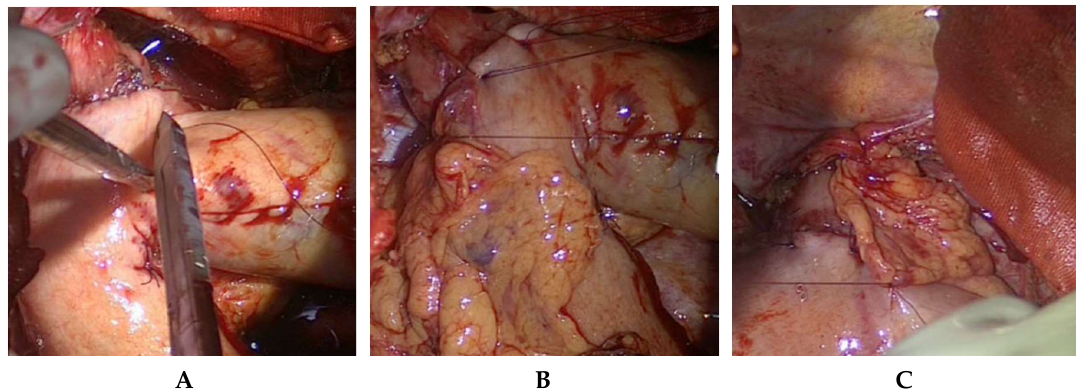
Figure 6. Oversewing of circular stapled esophagogastrostomy ( A , B ) and semifinished anastomotic omentopexy ( C ).